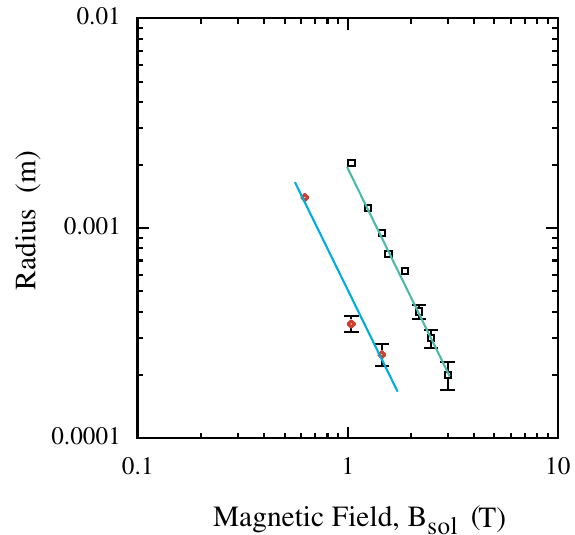
FIG. 18. (Color) Radii of beamlets as a function of solenoidal field. The upper set of data comes from the inner band.